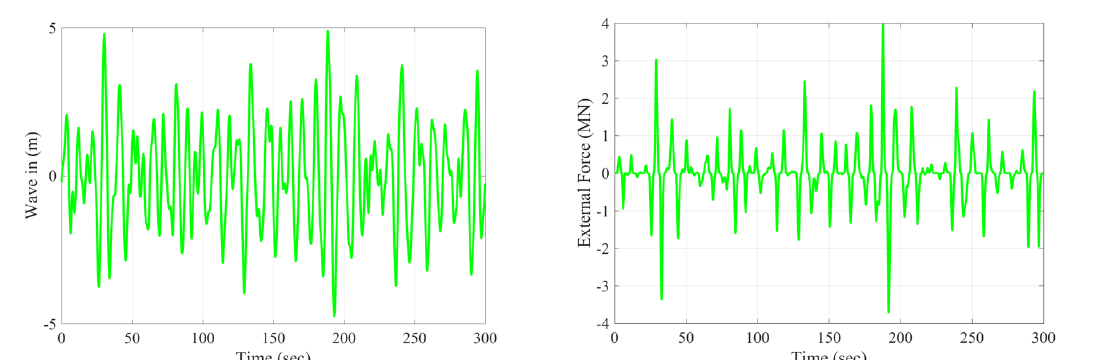
Figure 20. SS4 external Bretschneider wave input ( left ) and external wave force ( right ), respectively.